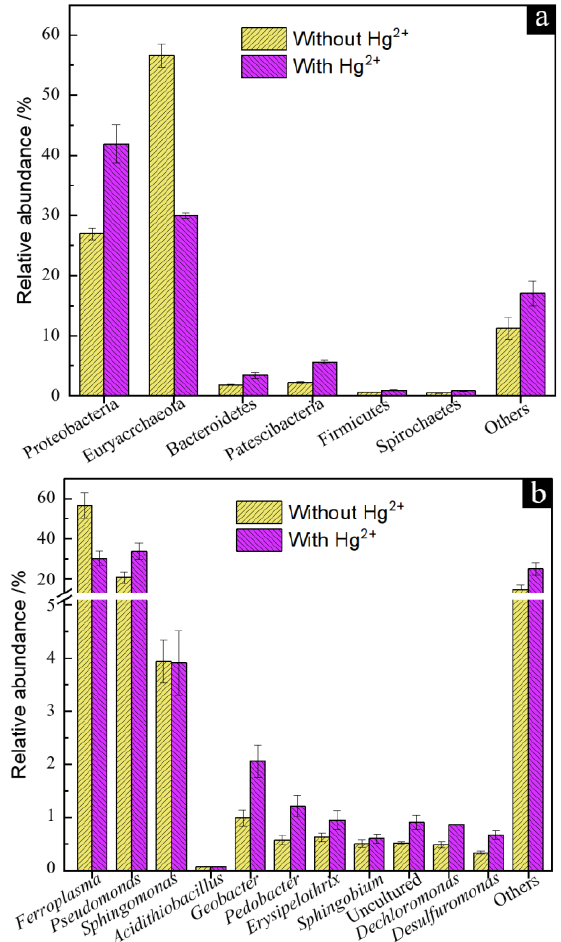
Figure 8. The microbial community composition histogram at the phylum level ( a ) and the genus level ( b ) for the groups without and with Hg 2+ .